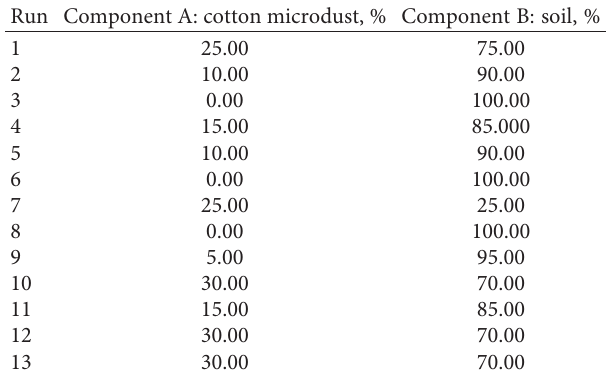
Table 3: Experimental plan of the brick production using Design Expert